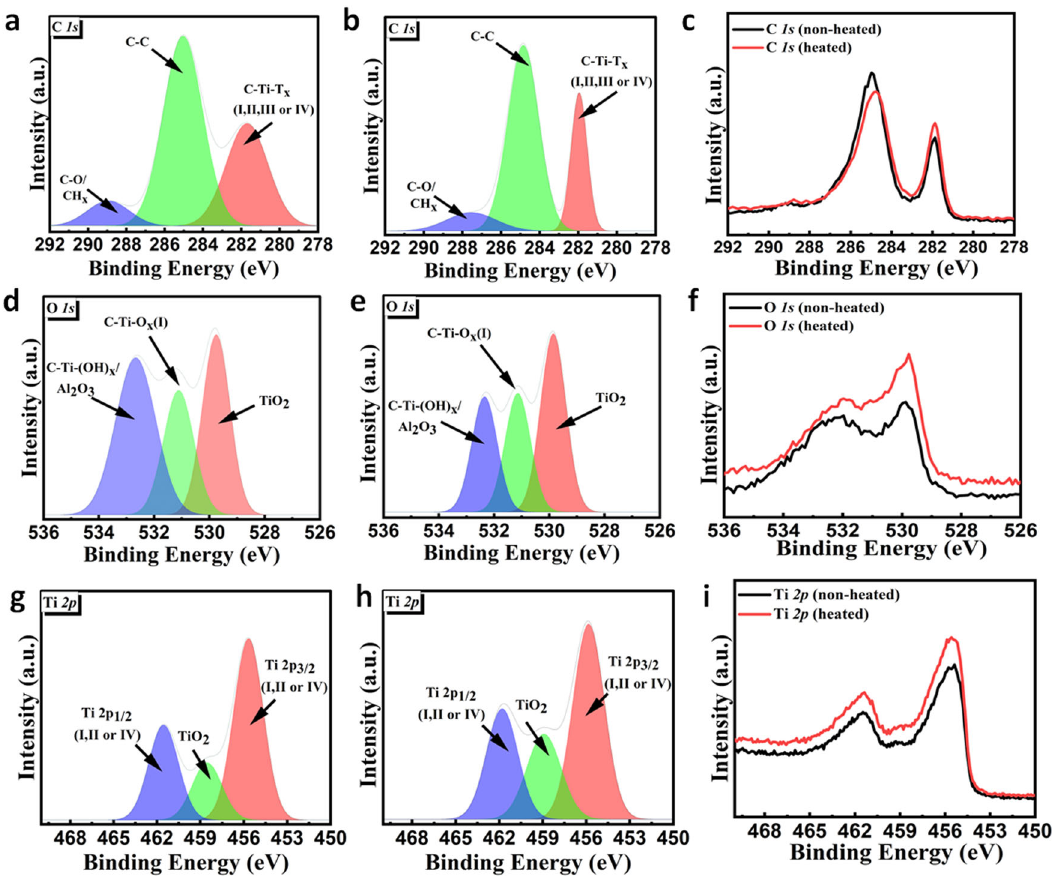
Fig. 2 X-ray photoelectron spectroscopy analysis. a , b C 1 s region. d , e O 1 s region. g , h Ti 2 p region (left column Ti 3 C 2 T x MXene fi lm, middle column HT-Ti 3 C 2 T x MXene fi lm and right column comparison between both of